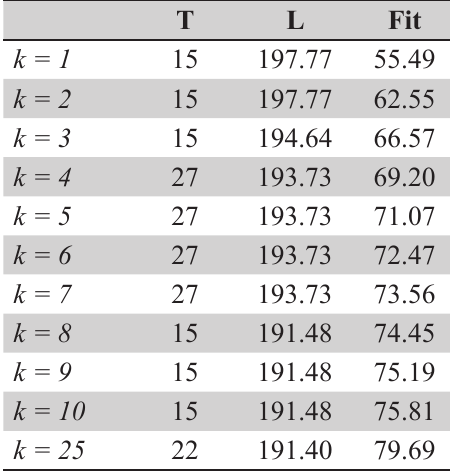
Table 2. Summary statistics from the implied weighting analysis. Abbreviations: k = concavity constant; T = number of topologies recovered; L =